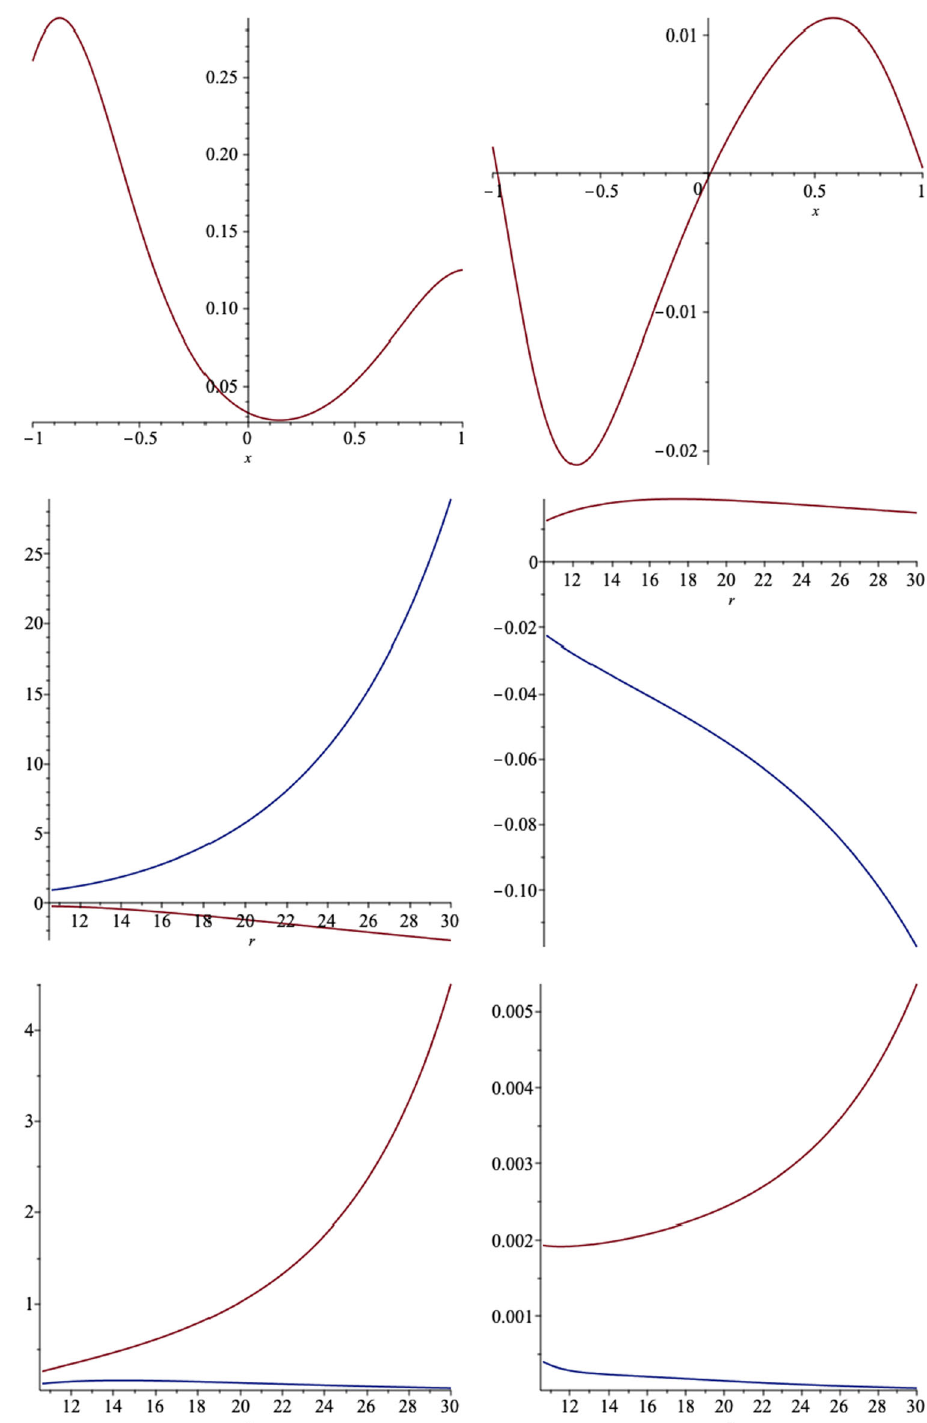
Fig. 9 The r (left) and x (right) components of the electric field, on the event horizon, versus x , for a black hole which the event horizon is located at r + = 10 . 6. We set the black hole parameters as a = 6 , q = 1 , m = 7 , l = 1 and b = 2